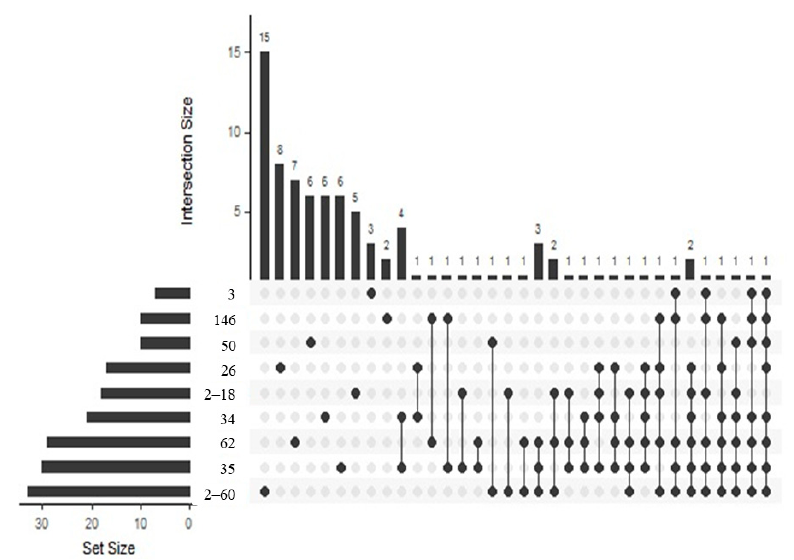
Figure 2. The venn diagram showing the amount of different and same VOCs released by different strains. The left side shows the total number of VOCs released by each strain, and the above shows the number of VOCs unique to each strain or shared with other strains.